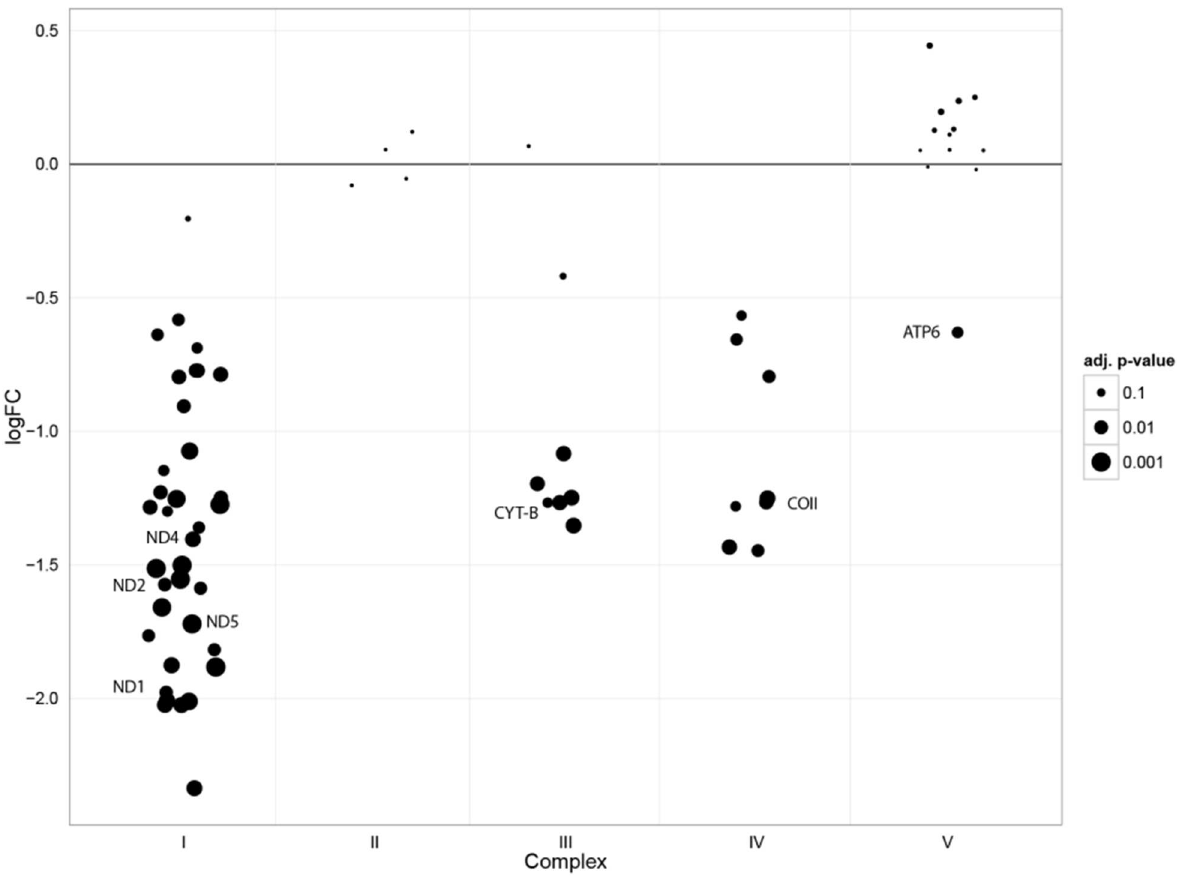
Fig 4. m.547A > Tfibroblasts display a marked reduction in complex I, III and IV protein expression. Four individualpairs of fibroblastsfrom different patients and controls wereSILAClabelledandthe mitochondrialfractionwasanalysedbyLC-MS/MS. Theratioof proteinlevelsinpatientversuscontrolcellsis displayedon a log2scale.Respiratory chainproteinswhichwerequantified inat leasttwopairs areshown.Allidentifiedmitochondrial-encodedproteinsareannotated (ND1-5:NADHdehydrogenasesubunit1–5,CYT-B:cytochrome b, COII: cytochromec oxidaseII, ATP6: ATP synthase 6. SeeS4 Fig for completeannotation). Thesizeof eachdot indicatesthe significance (adjustedp value)of the differencein abundanceof the proteininthe patientandcontrolsamples.Locationbelowthe lineof equivalence(0.0) indicateslowerabundanceinthe patientsamplescompared to controls.